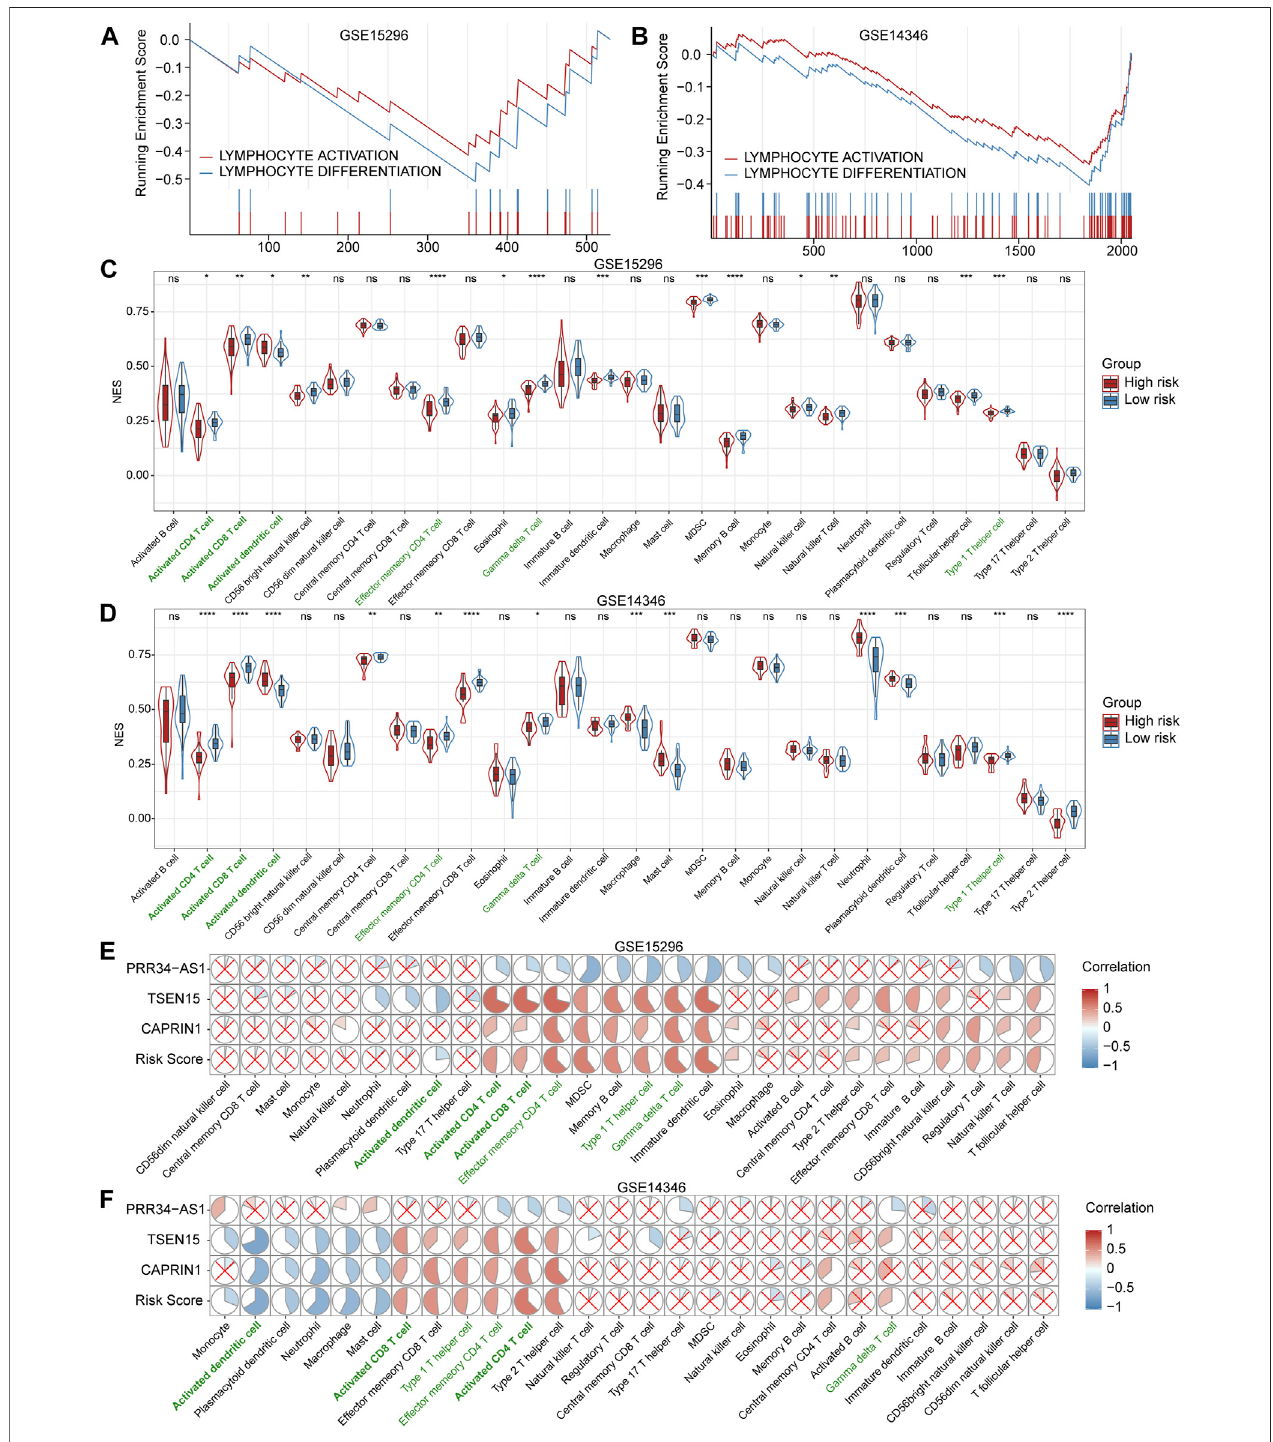
FIGURE 5 | Gene set enrichment analysis (GSEA) and assessment of immune cells (A and B) GSEA plots show signi fi cantly enriched immune-related biological processes associated with the diagnostic model in the training (GSE15296) and validation (GSE14346) cohorts (C and D) Violin and box plots for comparisons of immune cell levels between high- and low-risk patients in the training and validation cohorts. Cells with statistically signi fi cant changes in both cohorts are labeled in green. * p < 0.05; ** p < 0.01; *** p < 0.001; **** p < 0.0001; ns, not statistically signi fi cant (E and F) Correlation heatmaps between the expression levels of three genesandimmunecelllevelsinthetrainingandvalidationcohorts.Thepiegraphsare fi lledinproportion totheSpearman ’ scoef fi cient values,anti-clockwizeforpositive correlations (in red) and clockwise for negative correlations (in blue), the red crosses represent no statistically signi fi cant correlations ( p > 0.05). NES: normalized enrichment score. MDSC: myeloid-derived suppressor